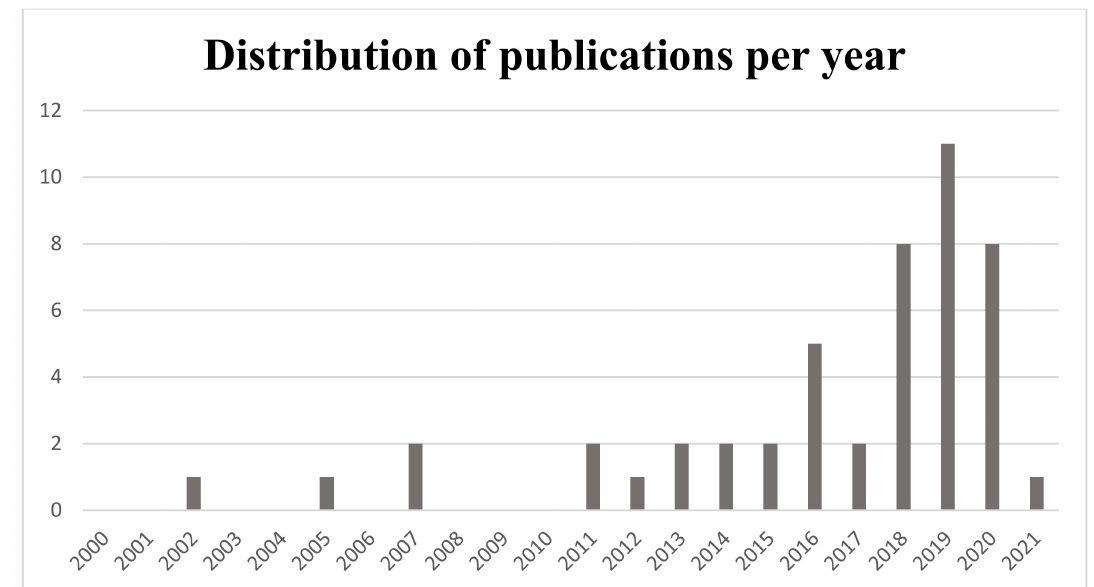
Figure 3. Distribution of the included studies according to the year of publication.